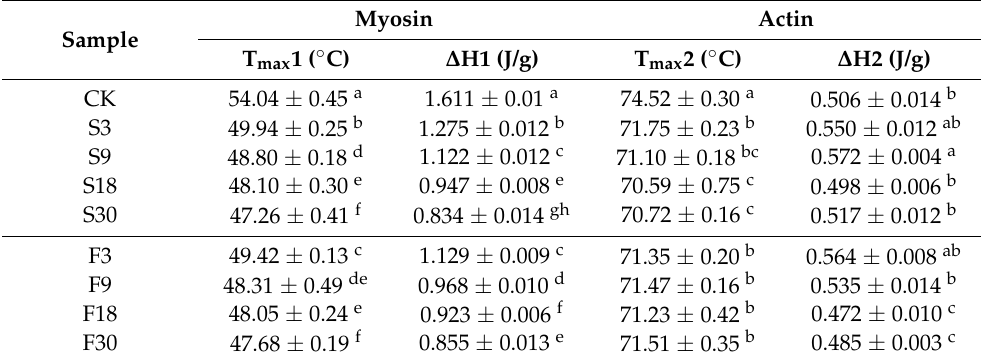
Table 2. T max and ∆ H values obtained of myosin and actin of large yellow croaker muscle during